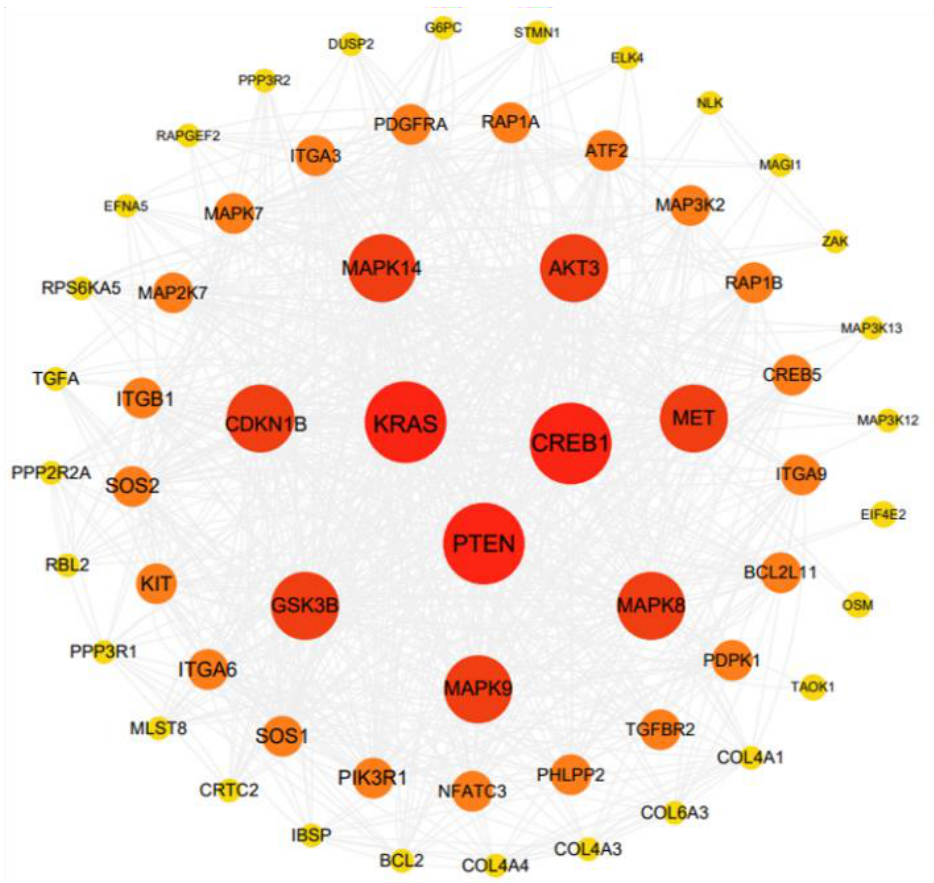
Figure 5. PPI network of the potential target genes of circRNA1709 . The larger the circle, the more proteins it interacts with, representing greater importance in the network.